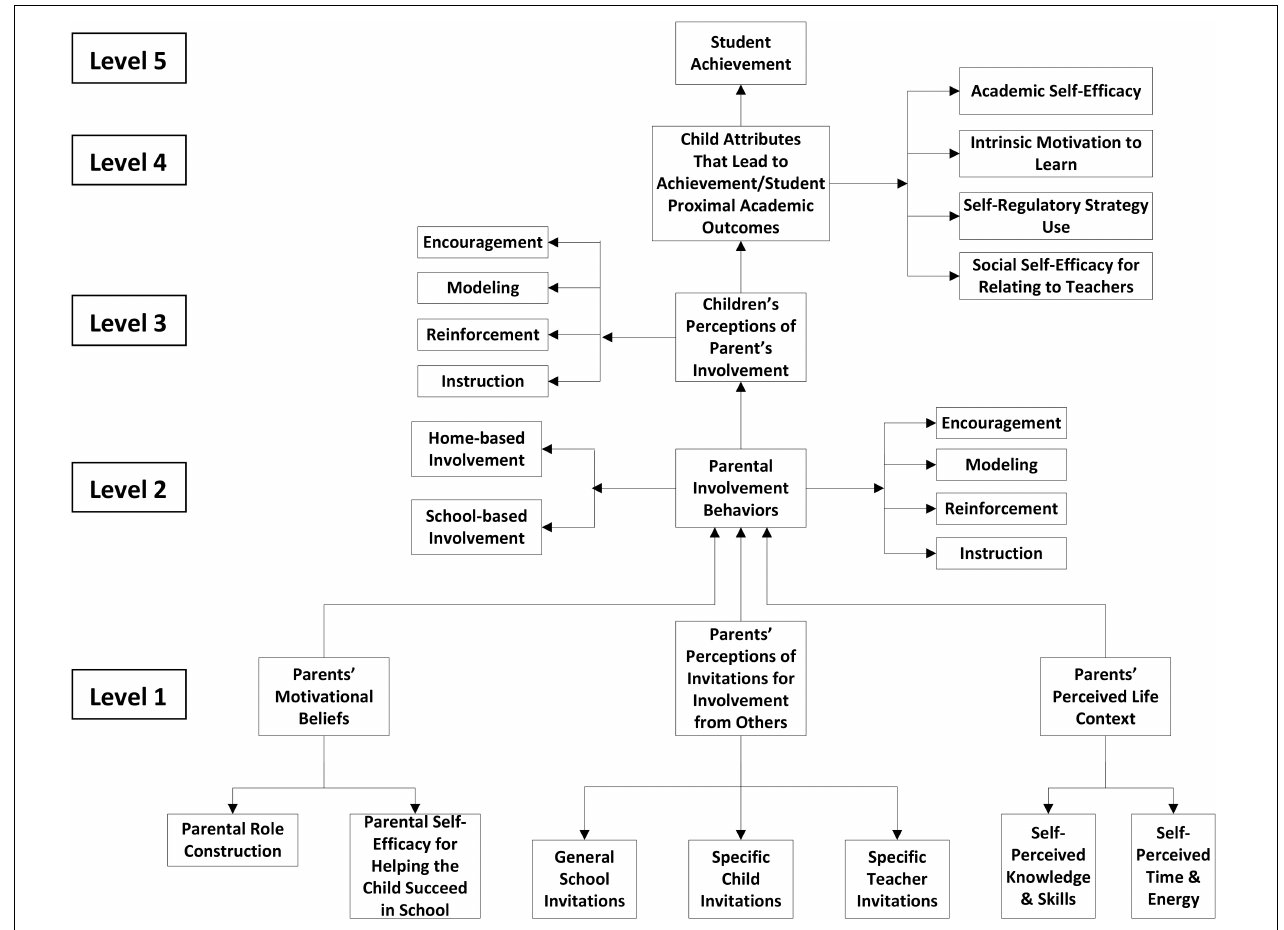
FIGURE 1 | Hoover-Dempsey and Sandler Model of the parental involvement process (Hoover-Dempsey and Sandler, 2005, p. 74).